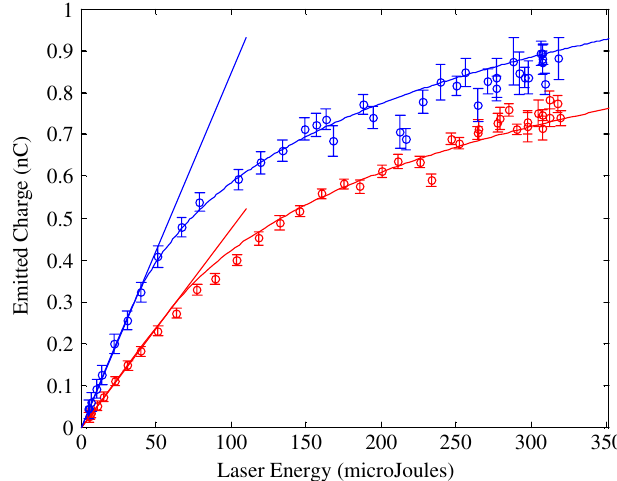
FIG. 14. (Color) The measured charge vs laser energy before (red) and after (blue) laser cleaning. The slopes of the straight lines give the QE and indicate the linearly increasing emitted charge with laser energy in the absence of space charge limited emission. The initial QE was 2 : 3 (cid:7) 10 (cid:1) 5 and after mild laser cleaning it was 4 : 1 (cid:7) 10 (cid:1) 5 .